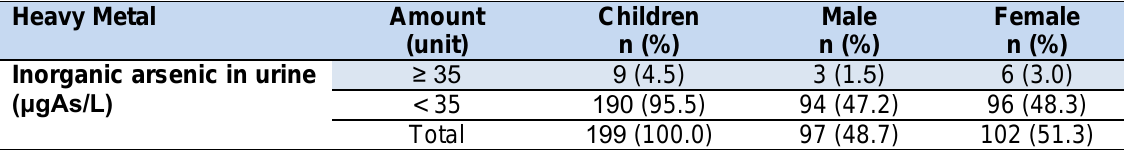
Table 4: Number and percentage of children who were analyzed for inorganic arsenic levels in urine sample (n=199)